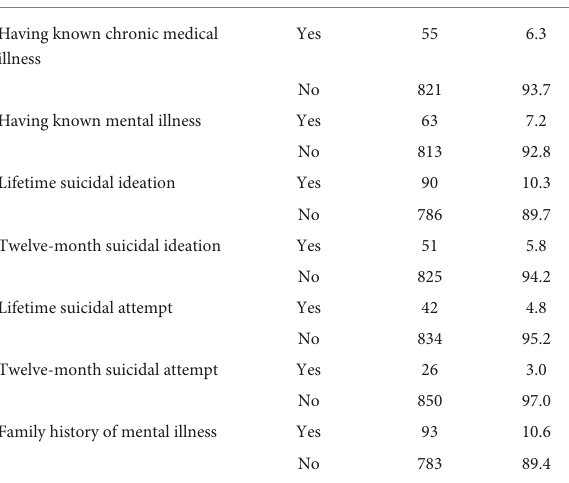
TABLE 2 Clinical characteristics of participants among high school adolescents in Northwest Ethiopia ( n = 876), 2021 Gorgonian Calendar (GC).